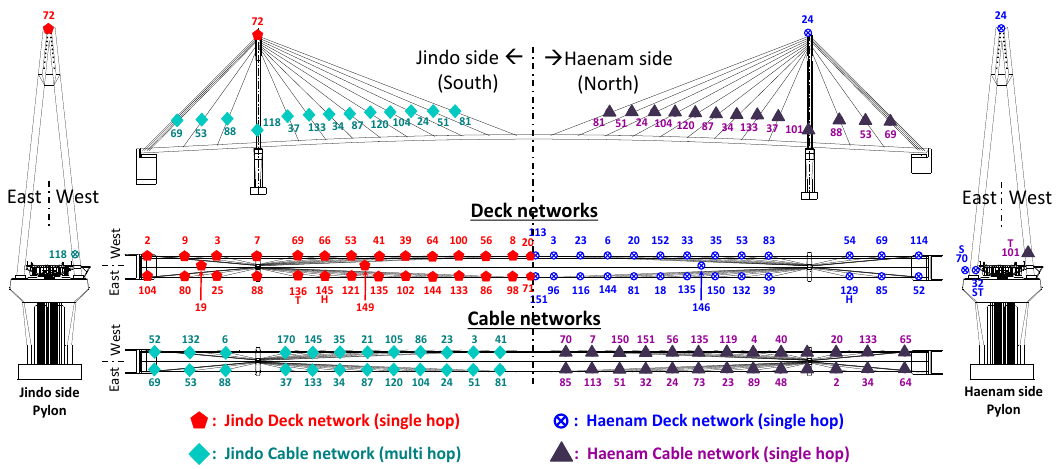
Figure 9. Jindo Bridge WSS networks layout.